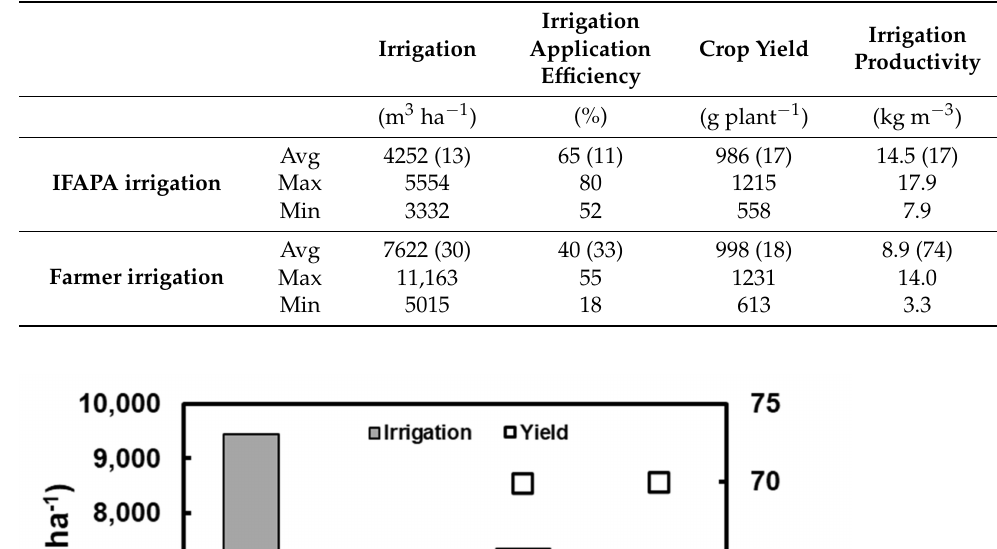
Table 2. Comparation of irrigation scheduled by farmer and IFAPA between 2012/2013 and 2016/2017 irrigation seasons (coefficient of variation in percent were indicated in parentheses).